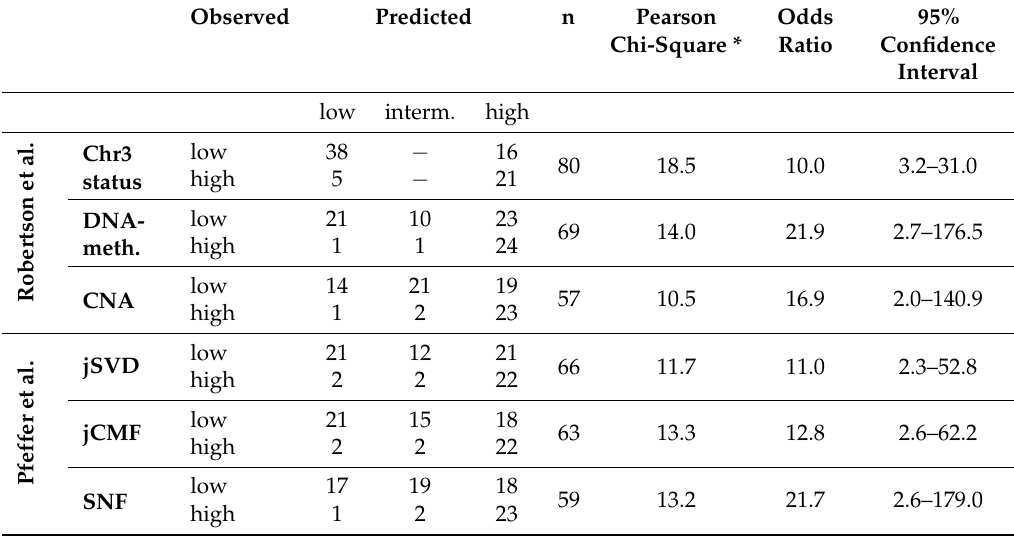
Table 1. Contingency table for risk